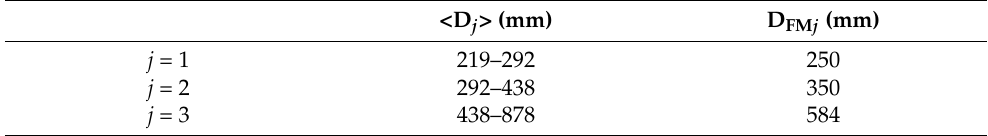
Table 6. Results of depth segmentation and depth-of-field